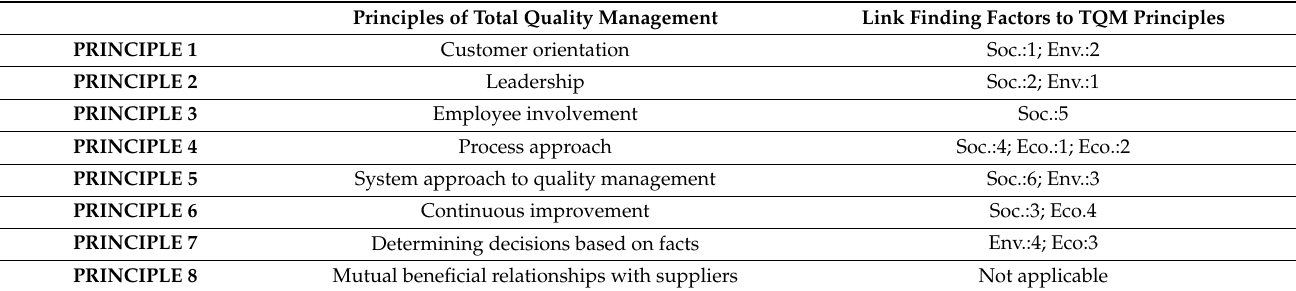
Table 8. Findings linked to TQM principles (source: own